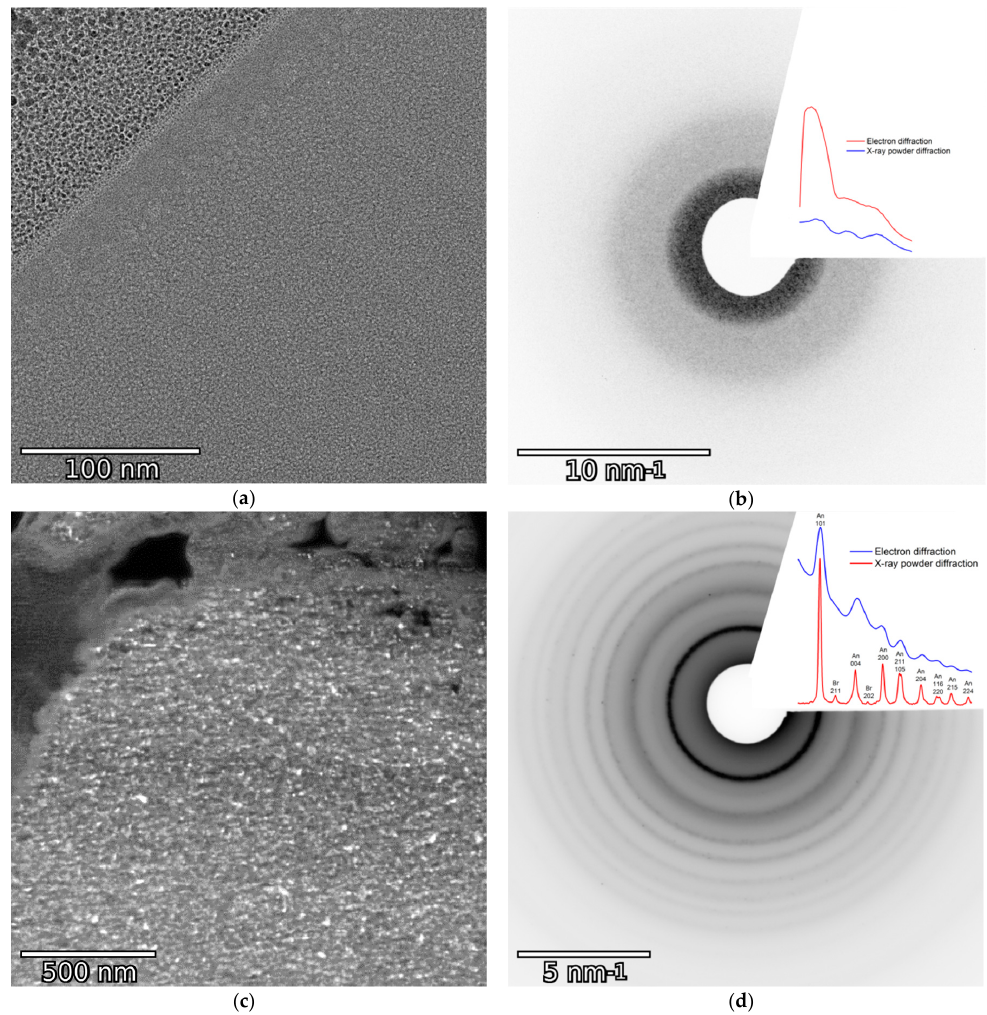
Figure 8. TEM image ( a ), ED and XRD ( b ) of the lamella cut out of the untreated spherical particle; dark-field TEM image ( c ), ED and XRD ( d ) of the lamella cut out of the particle hydrothermally treated at 200 °C for 24 h.